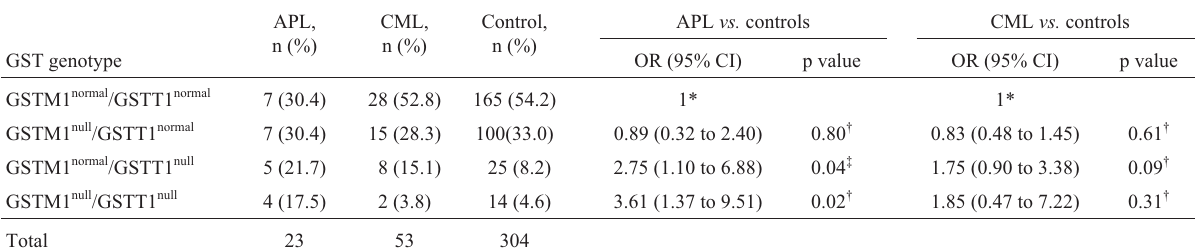
Table 1 - The glutathione S-transferase ( GST ) GSTT1 and GSTM1 polymorphism genotype distribution plus the odds ratio (OR) and 95% confidence in- tervals (CI) for acute promyelocytic leukemia (APL) patients (n = 23) and chronic myeloid leukemia (CML) patients (n = 53) as compared to apparently healthy control individuals (n =